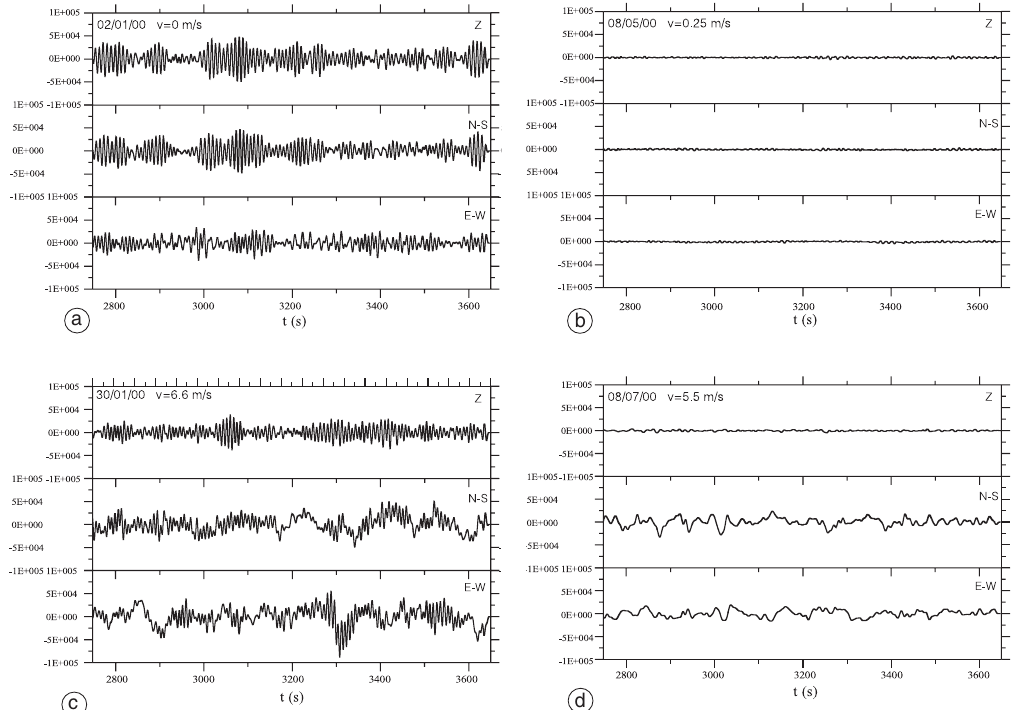
Fig. 3a-d. Original (without correcting for instrumental response) noise recordings of EBR station in winter (a and c) and in spring and summer (b and d) for different average wind speed (calm and windy periods). 15 min length three-component recordings starting at 3:00 local time are